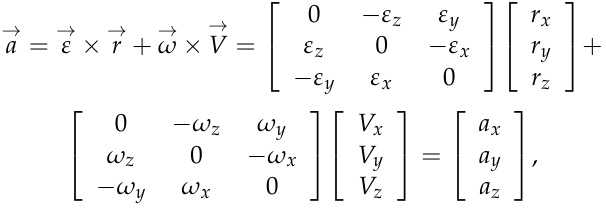
Figure 11. Where: V x , V y , V z are components of the velocity vector in the constant point C; ω x , ω y , ω z are components of the rotational velocity vector coordinate system in the constant point C; r x , r y , r z are components of radius vector coordinate system in the constant point